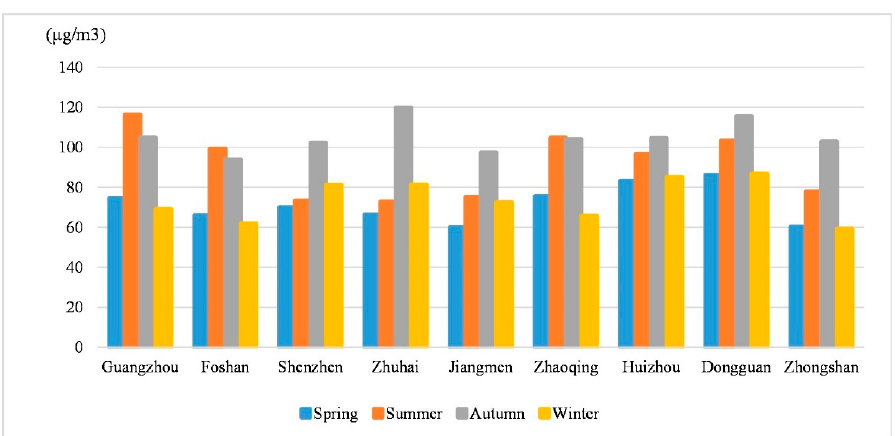
Figure 5. Seasonal variation characteristics of ozone concentrations in nine prefecture-level cities in the Pearl River Delta Metropolitan Region. Table 3. Seasonal average ozone levels in various cities in urban areas of the Pearl River Delta. City